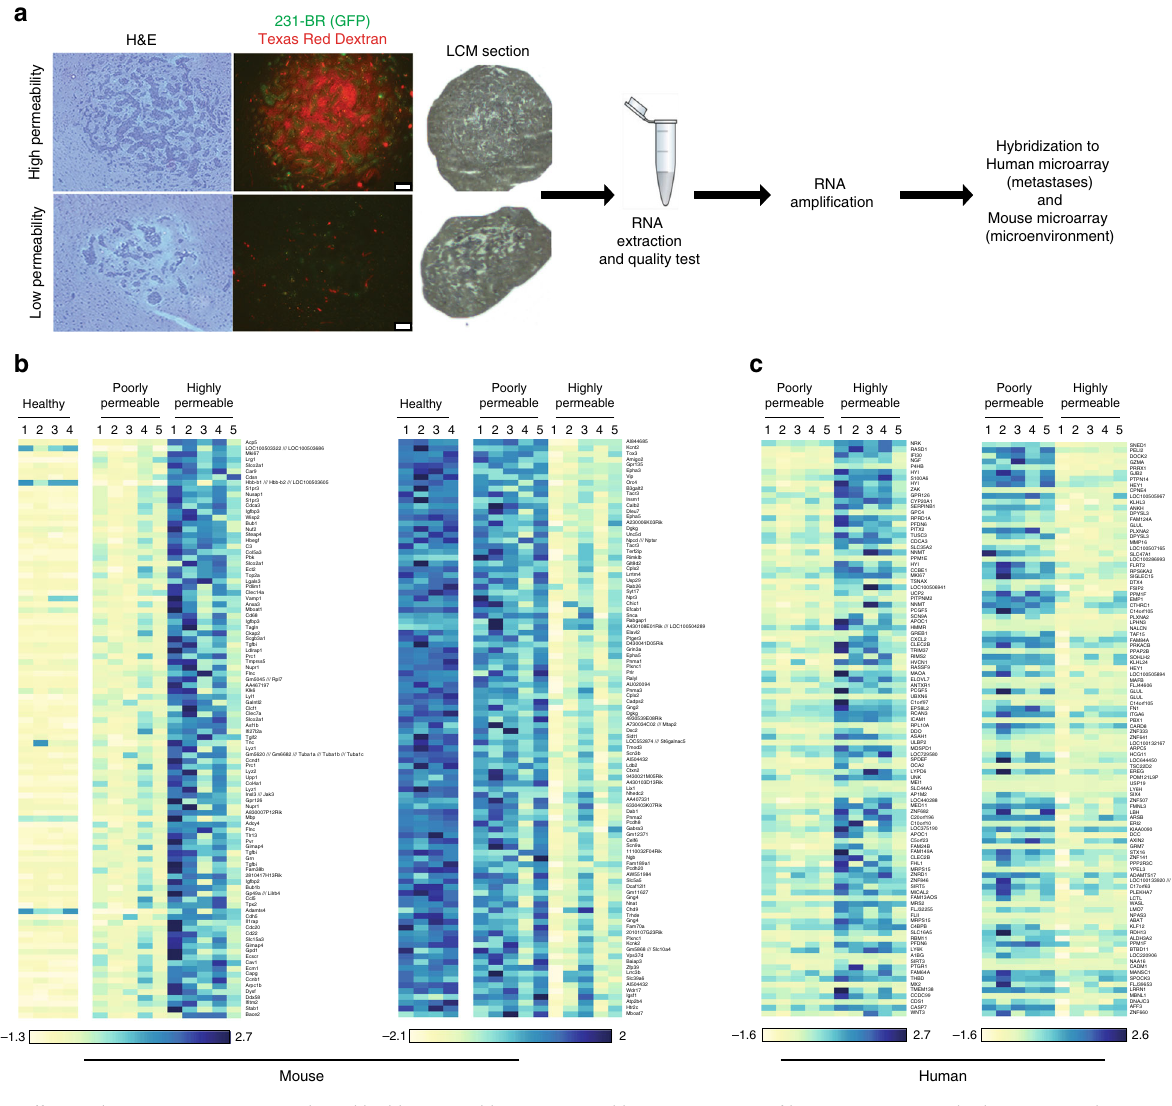
Fig. 1 Differential gene expression in poorly and highly permeable experimental brain metastases of breast cancer. Mice harboring GFP + brain metastases of MDA-MB-231-BR (231-BR) triple-negative breast cancer cells were administered 3 kDa Texas Red Dextran (TRD) as an indicator of paracellular permeability, and perfused at necropsy to remove TRD from blood vessels. Highly permeable and poorly permeable metastases from a single mouse brain were collected by laser capture microdissection, and microarray gene expression analysis performed. Both metastatic cells and the immediate microenvironment were captured for fi ve mice. a Example of poorly and highly permeable metastases from a single mouse brain and a schematic of the procedure. A section showing TRD exudation (red) and the adjacent H&E stained section are shown (scale bar = 100 µ m). b Differentially expressed murine (brain microenvironment) genes between poorly and highly permeable metastases. Normal brains from healthy mice were included for comparison. c Differentially expressed human (metastatic cells) genes between poorly- and highly-permeable metastases. Numbers above indicate mouse